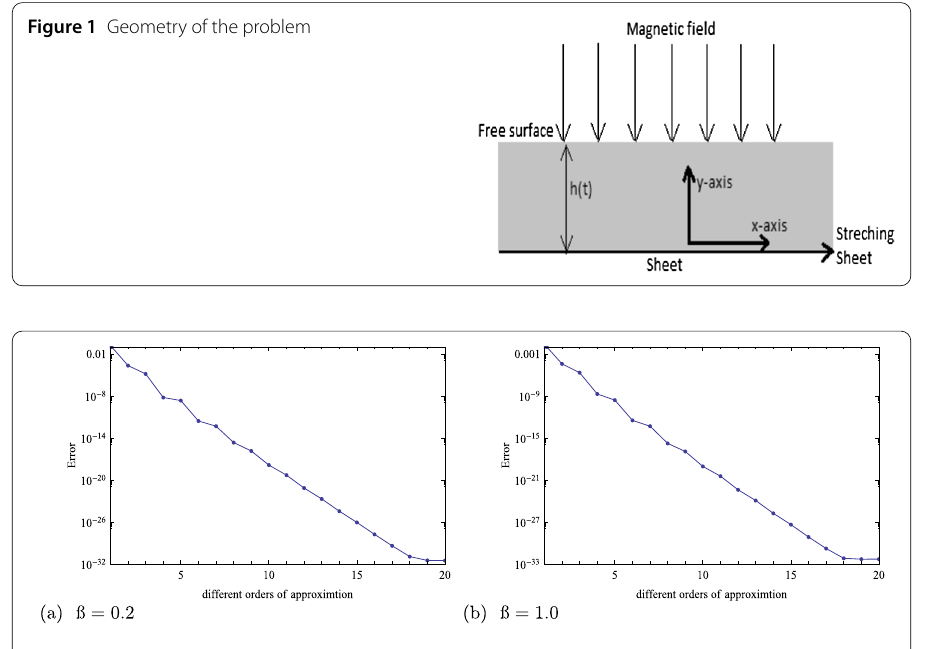
Figure 3 Error of azimuthal velocity f at 20th-order HAM via Mathematica package BVPh2.0 approximation, where β = 0.2, I 0 = 0, λ = 0.2, A = 0.3, N = 0.2, S = 0.4, Ma = 1, M = 1, Υ = 0.127013, Pr =